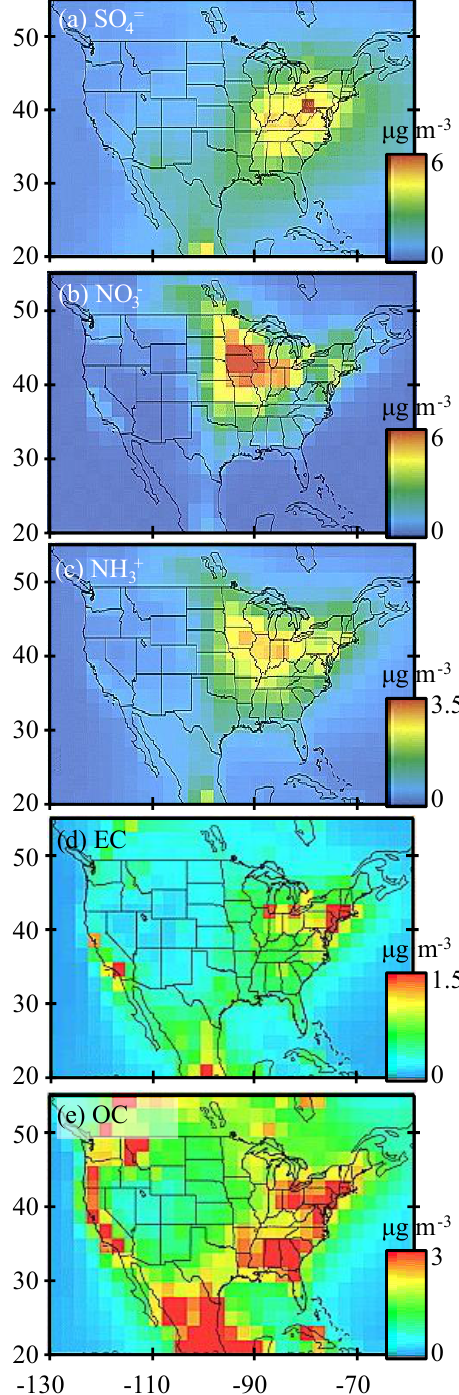
Figure 4. Mean surface concentrations of the (a) SO = (c) NH + , (d) EC and (e) OC in North America obtained in previous 3 studies by GEOS-CHEM modelling and validated with the observa- tions in the network IMPROVE (Park et al., 2003,2004, Copyright by the American Geophysical